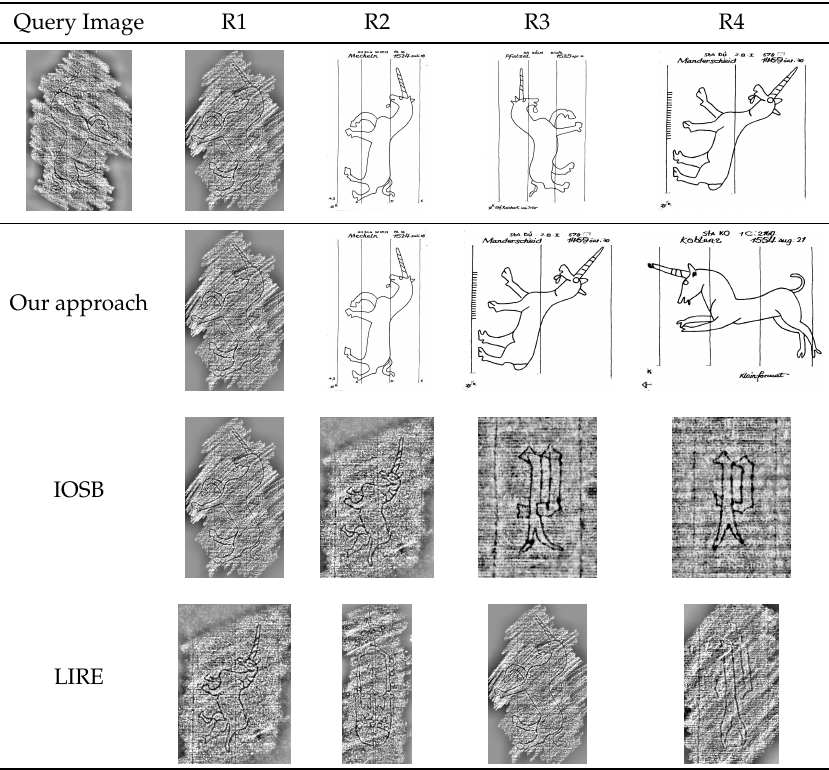
Figure 6. The top row shows a query image belonging to class Fabulous Creature/Unicorn and the first 4 results annotated by an expert (used as ground truth for evaluation). The second row shows the results (R1 through R4) retrieved by our approach when pre-trained for tagging and fine-tuned for similarity. Notice that the images all belong to the correct class. The third row shows the results retrieved by the IOSB system [67] and the last row those of the LIRE system [68]. In these cases, occasionally some of the retrieved images belong to another class. It is also clear that the IOSB and LIRE systems are much less robust against different reproduction techniques, since these systems tend to return similar reproduction techniques (rubbings, radiographies) rather than similar